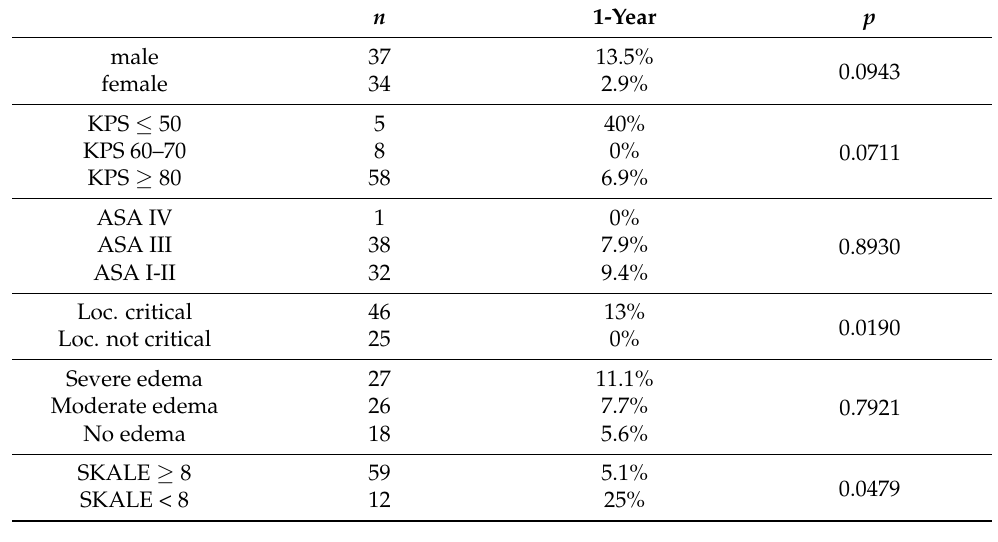
Table 3. Single factor analysis of the SKALE parameters regarding their influence on one-year mortality.